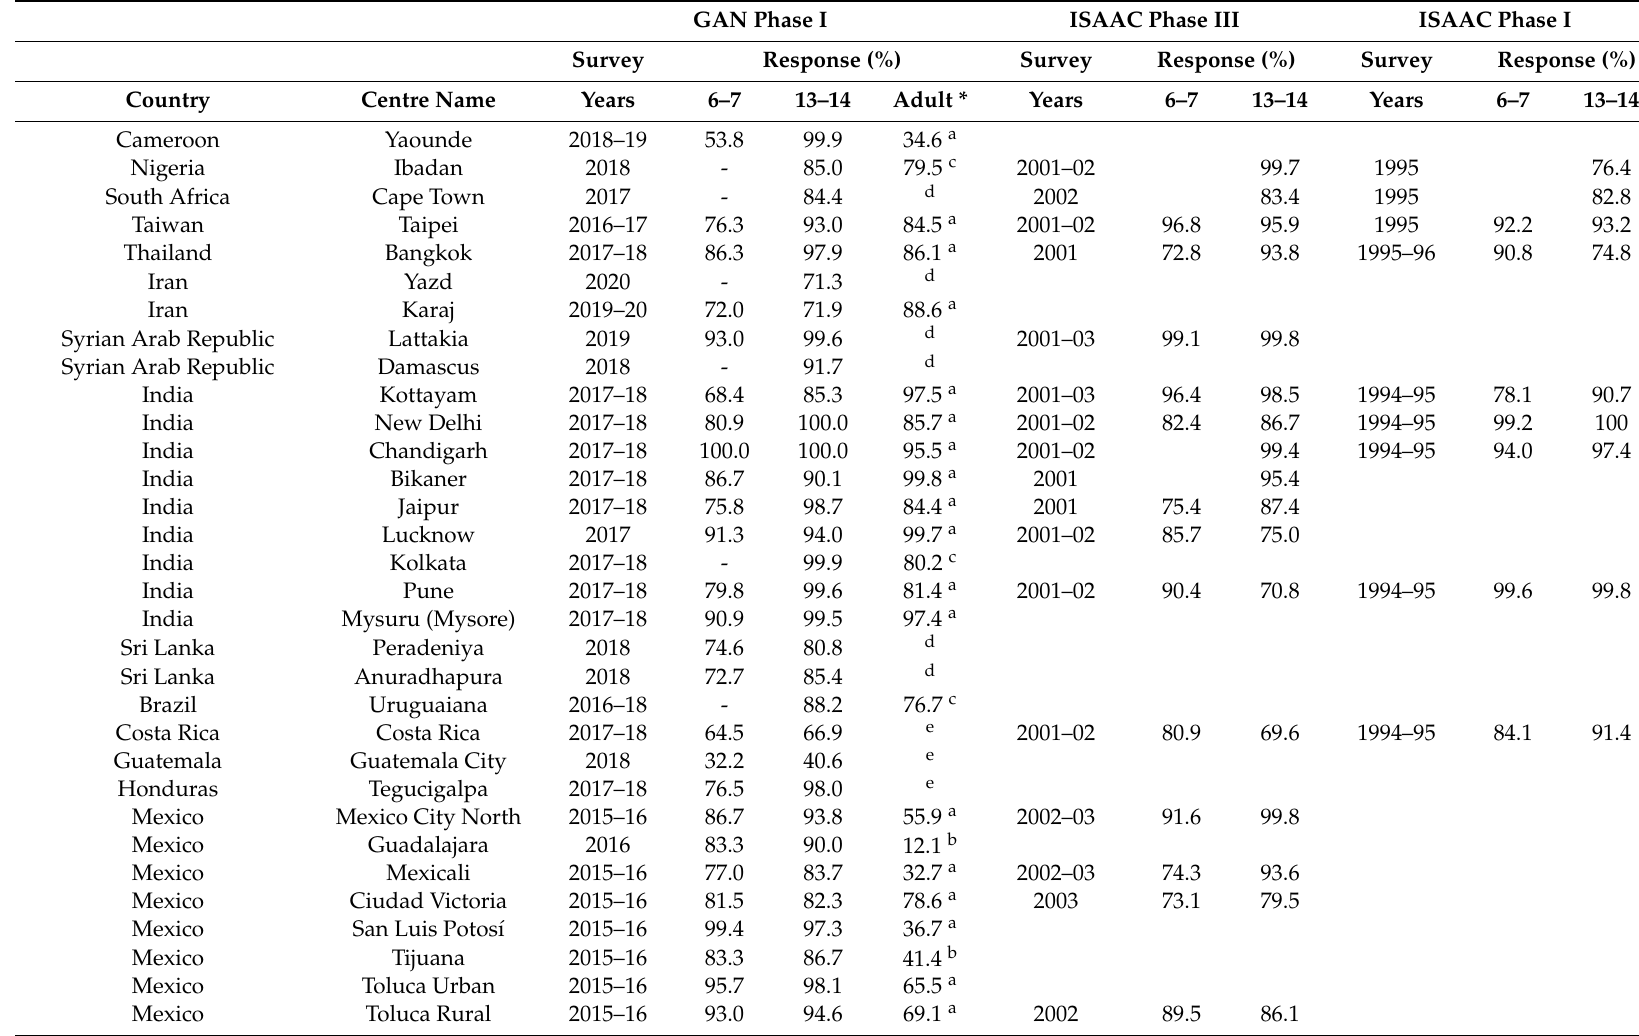
Table 3. Response rates for 6–7 and 13–14 year age groups to the written symptom questionnaires in GAN Phase I, ISAAC Phases I and III, by study centre and age-group. (The adult response rate was estimated on a “per child” basis *).